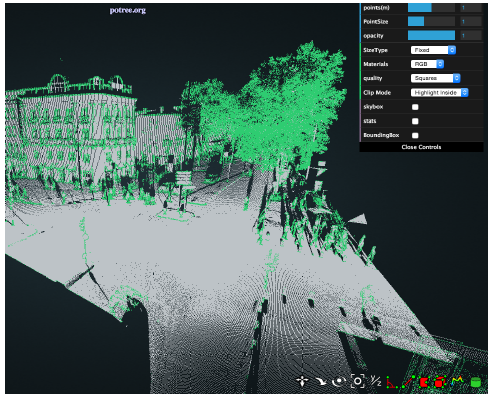
Figure 2: The user interface of